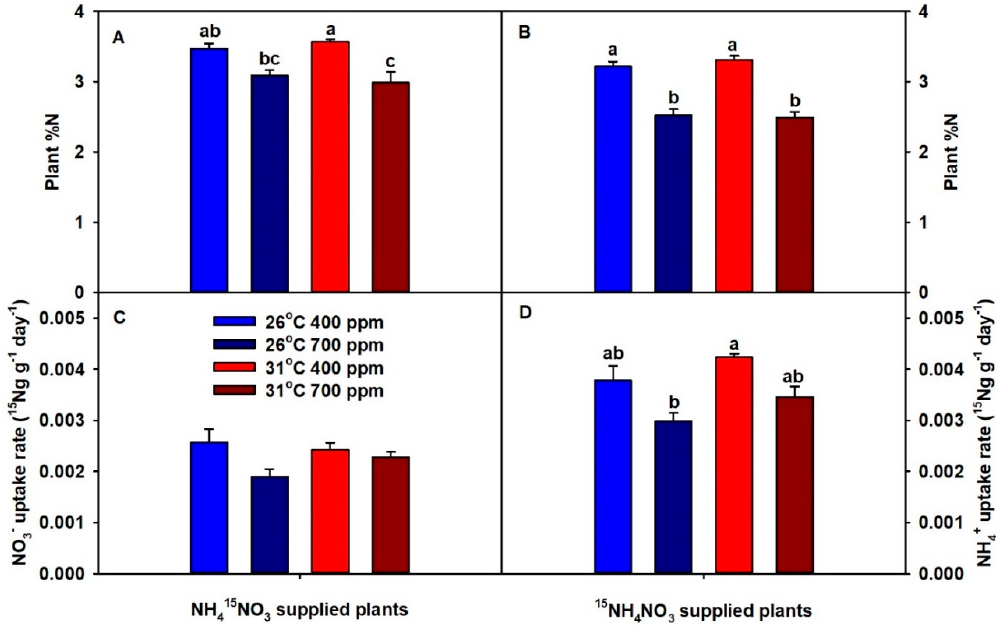
Figure 2. The effects of ambient (400 ppm) vs. elevated (700 ppm) CO 2 and near-optimal (26 °C) vs. chronic warming (31 °C) daytime temperatures on ( A ) plant %N and ( C ) NO 3 − -uptake rate of NH 415 NO 3 -supplied and ( B ) plant %N and ( D ) NH 4+ -uptake rate of 15 NH 4 NO 3 -supplied Triticum aestivum cv. Glenn plants grown for 21 or 23 days, respectively. Each bar represents mean ( n = 4 or 5) + 1 SEM. Within each panel, bars not sharing the same letters are significantly different ( p < 0.05, Tukey’s test).